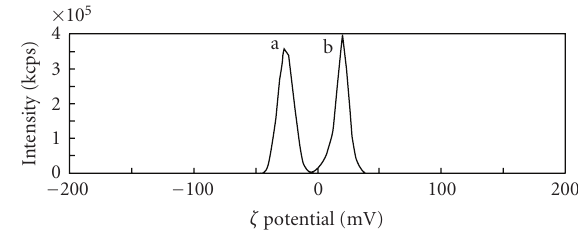
Figure 7: Zeta potential of MB solution (a) pH = 9; (b) pH = 2.